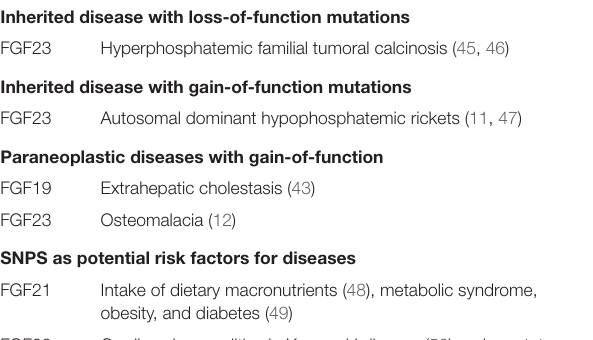
TABLe 2 | Roles of endocrine FGFs indicated by human diseases. inherited disease with loss-of-function